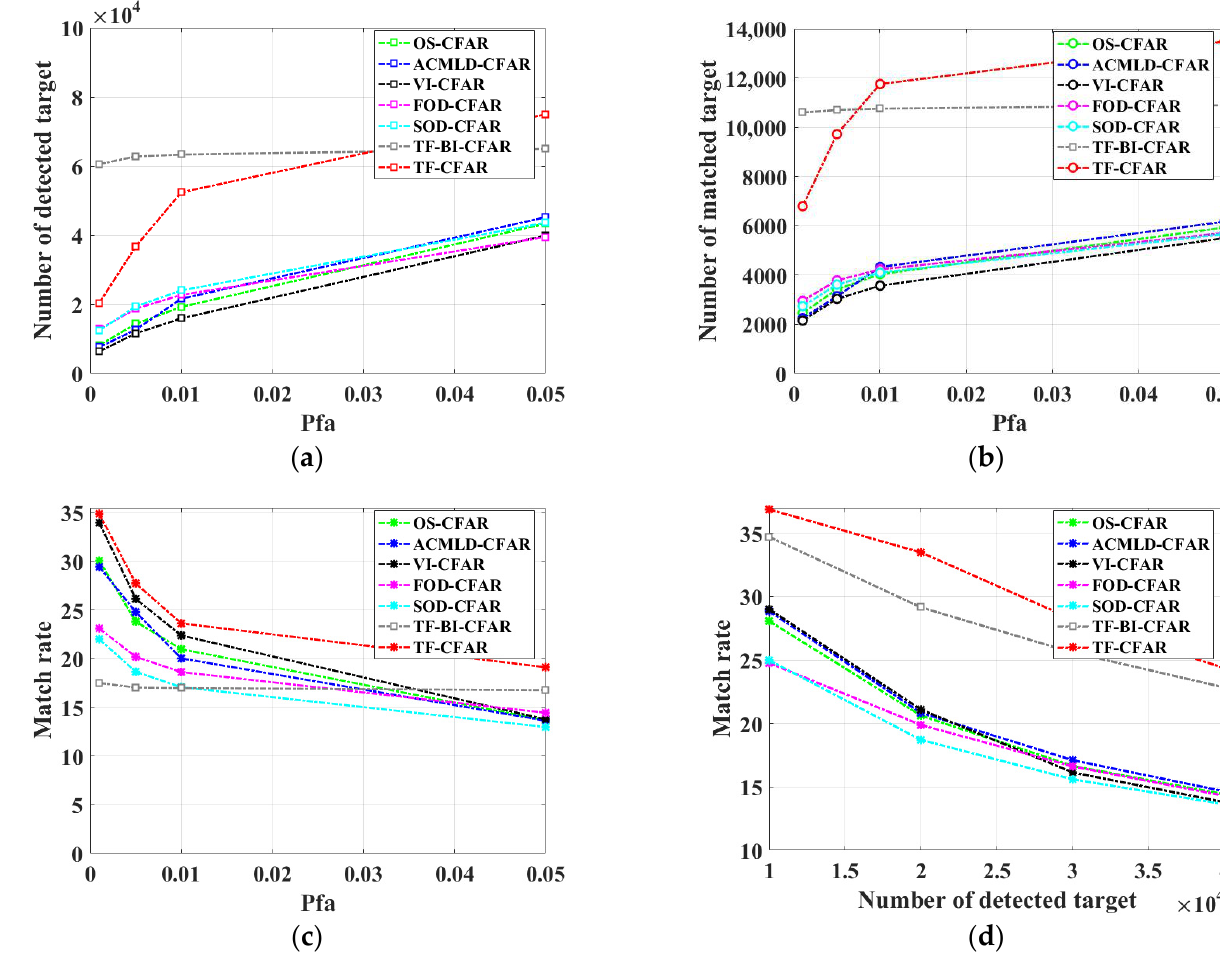
Figure 9. Number of detected and matched targets by seven CFAR detectors under different P fa on 5 October 2015. ( a ) number of detected targets under different P fa ; ( b ) the number of matched targets under different P fa ; ( c ) match rates under different P fa ; ( d ) match rates under the same number of detected targets. Table 3. Comparison of matched targets by seven CFAR detectors under the same number of detected targets on 5 October